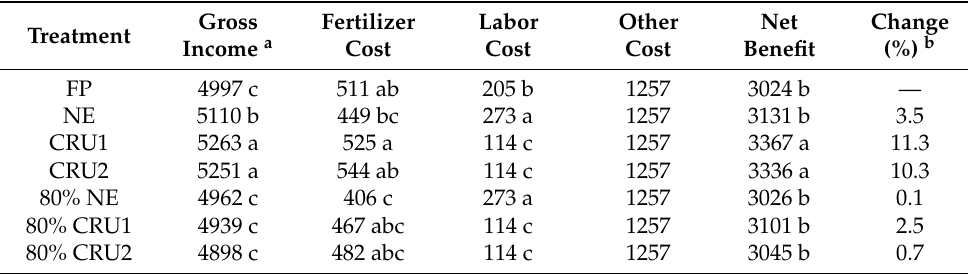
Table 4. Gross income, costs, and net benefits ($ ha − 1 y − 1 ) of different fertilizer treatments aver- aged over four growing seasons in a wheat–maize rotation from June 2015 to June 2019 in north- central